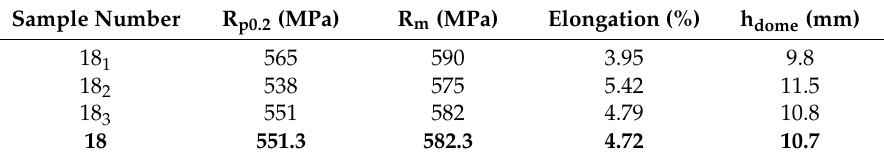
Table 5. Mechanical properties of tested steel sheet obtained by biaxial tensile test (test specimen No. 18): the bold represents average